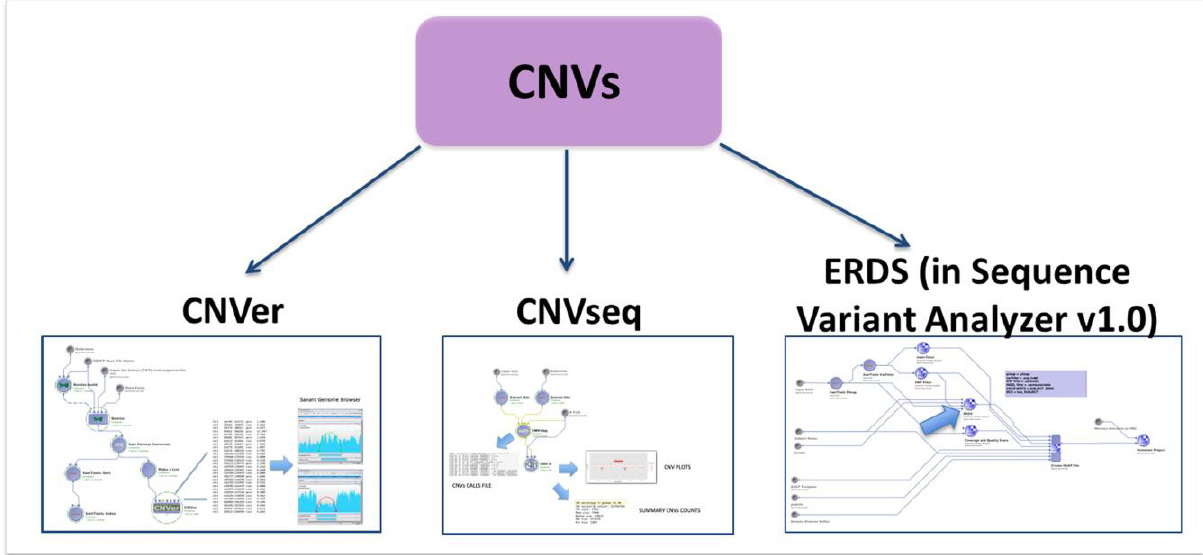
Figure 8. A snapshot of the general organization of the CNVs modules. ERDS, CNVer